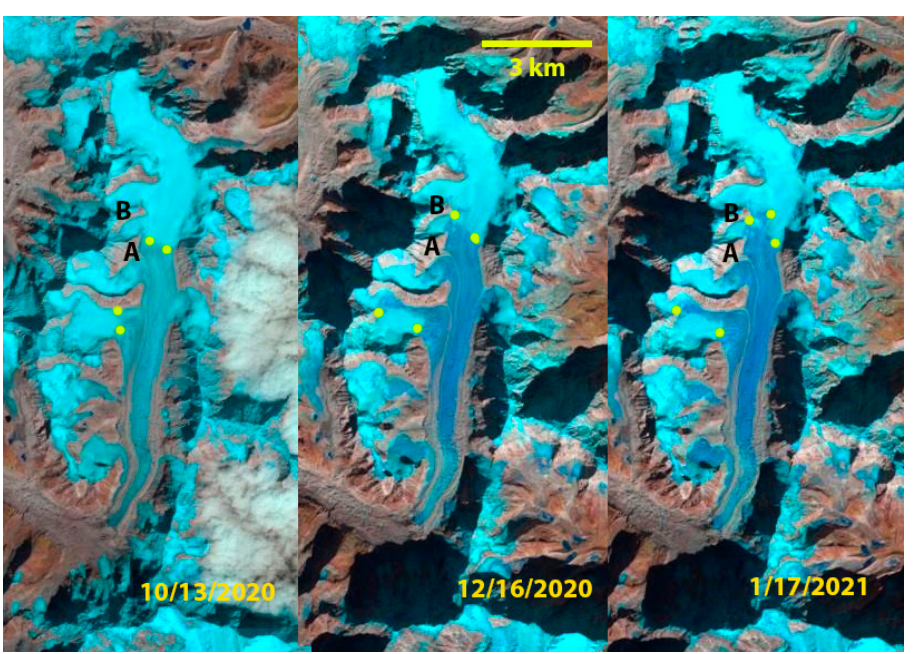
Figure 4. Transient snow lines on Rolwaling Glacier in Landsat images from 13 October 2020, 16 December 2020, and 17 January 2021. Yellow dots mark locations of snow line elevation determination. Table 1. Snow line elevation (meters above sea level) on selected glaciers from Landsat image observations indicating the increase both from October 2017 to February 2018 and from October 2020 to January 2021. Glacier